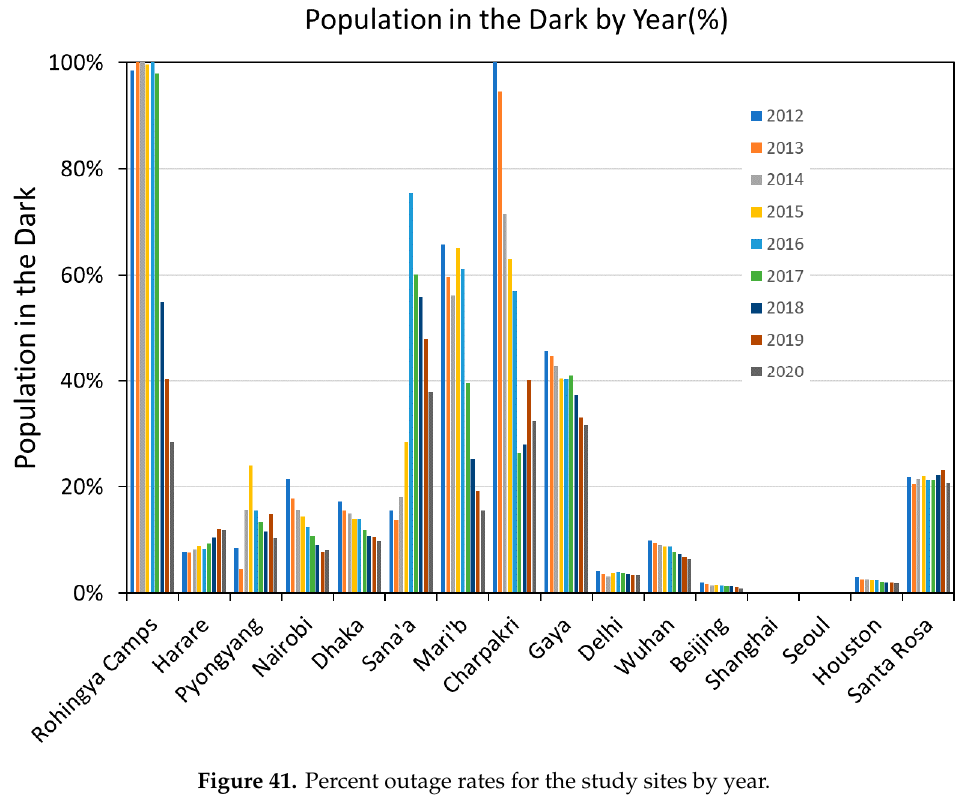
Figure 41. Percent outage rates for the study sites by year.